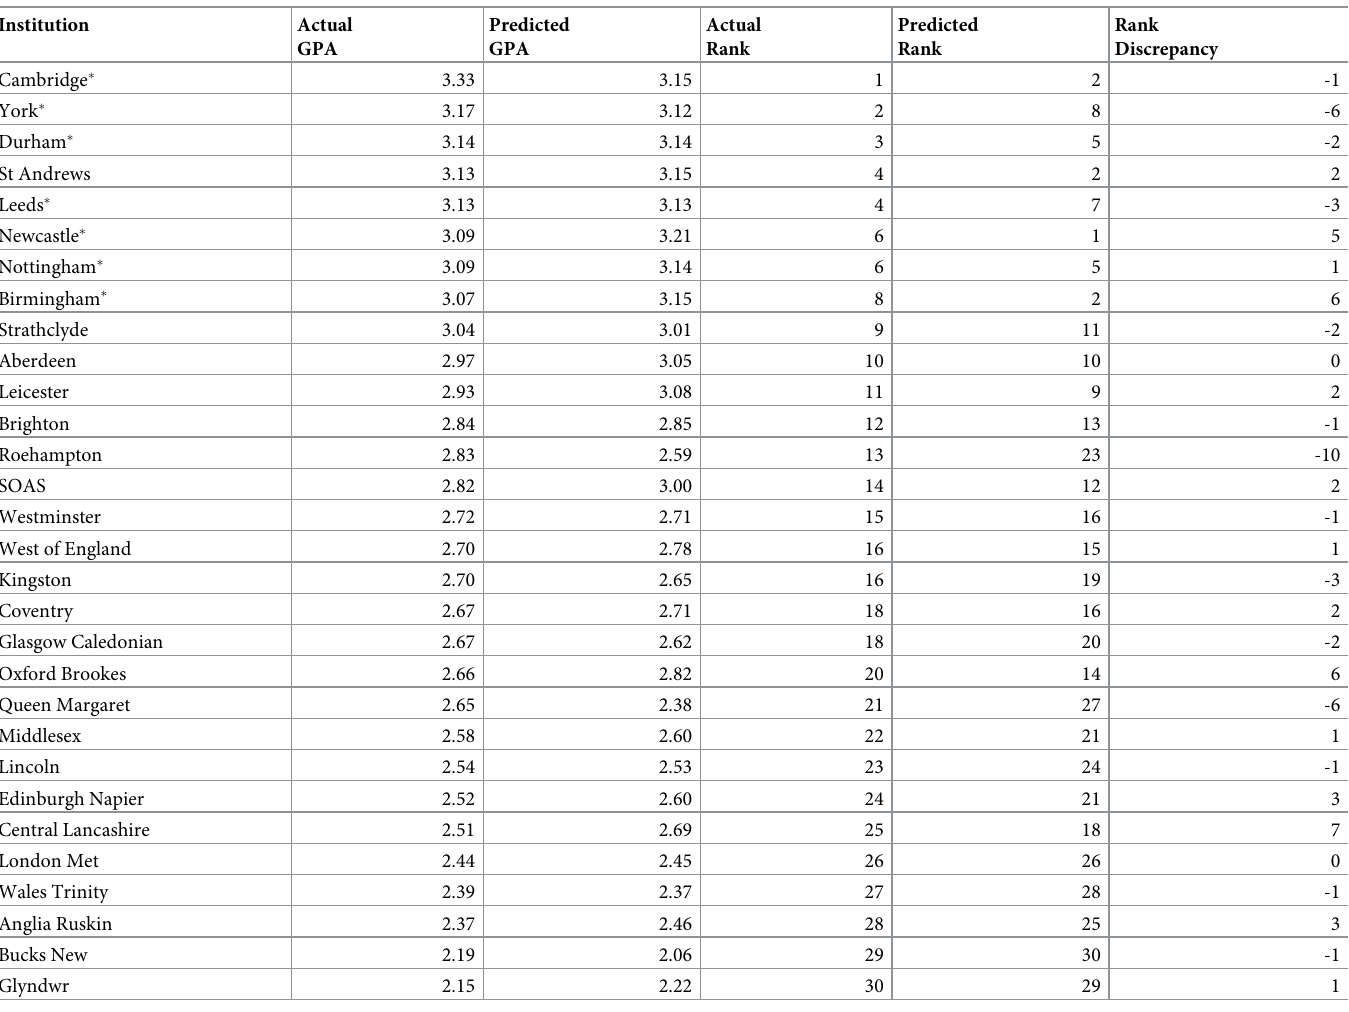
Table 2. Actual and predicted GPAs (Ranks) in the testing subset (n =